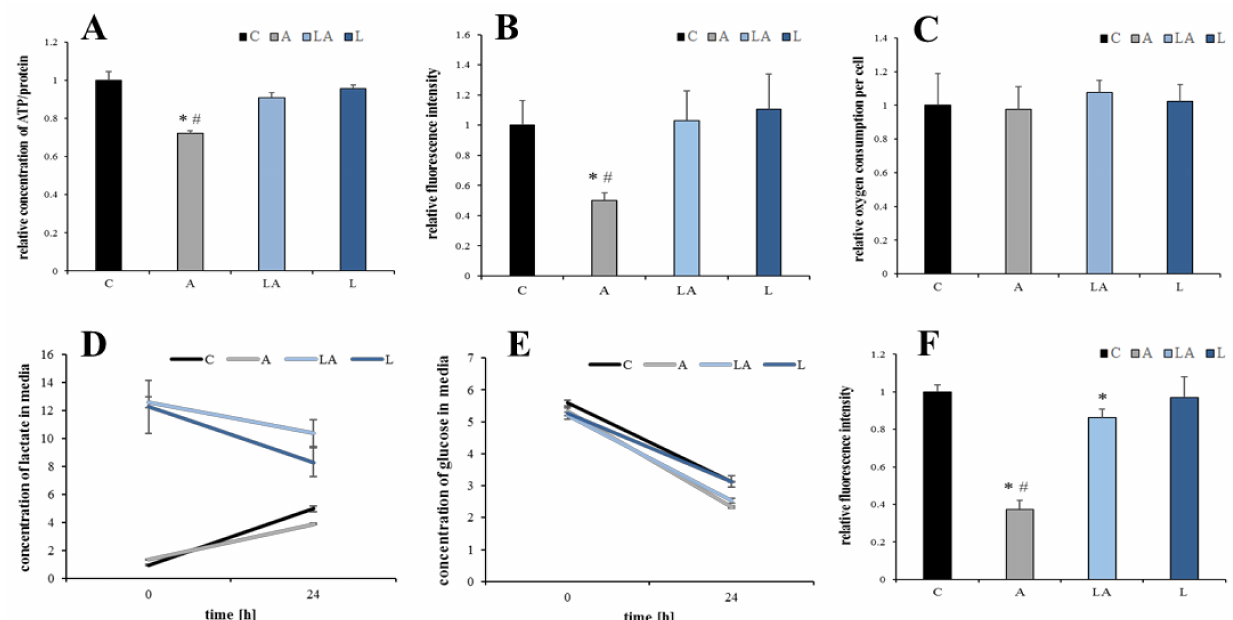
Figure 7. The effect of lactic acidosis on cancer cell metabolism. PaTu-8902 cells were treated with the experimental media for 72 h and ( A ) concentration of total cellular ATP, ( B ) mitochondrial membrane potential, ( C ) oxygen consumption, the changes in ( D ) lactate and ( E ) glucose levels in the culture media, and ( F ) mass of cellular phospholipids were determined. C, control; A, acidosis; LA, lactic acidosis; L, high lactate (* p < 0.05 compared to C, # p < 0.05 when comparing A and LA).